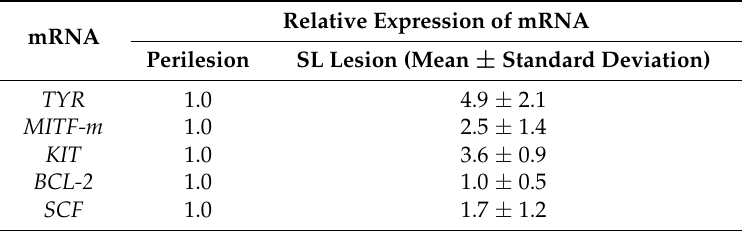
Table 1. Comparison of the relative expression of TYR , MITF-m , KIT BCL-2 , and SCF mRNAs in SL lesion and perilesion samples.